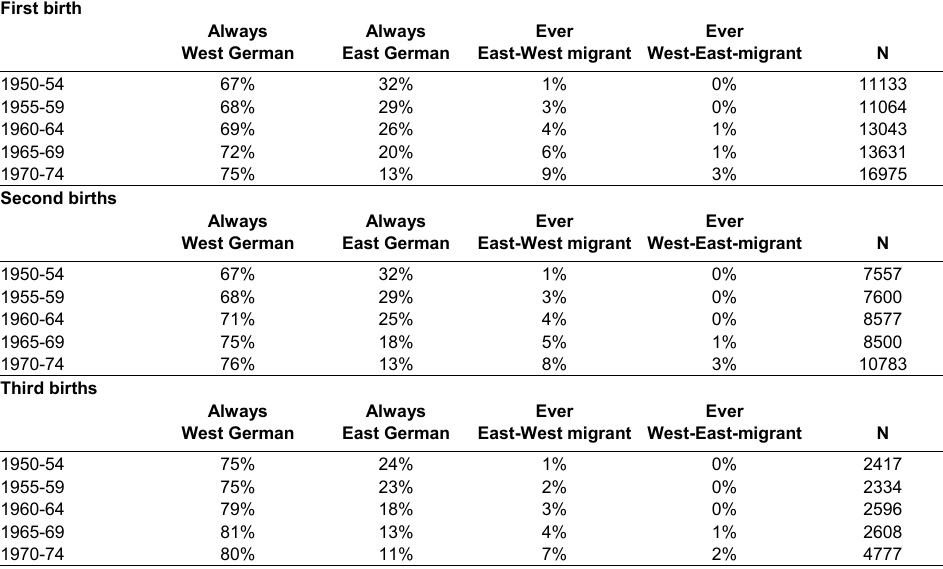
Table A2 : Births by region and birth order, row